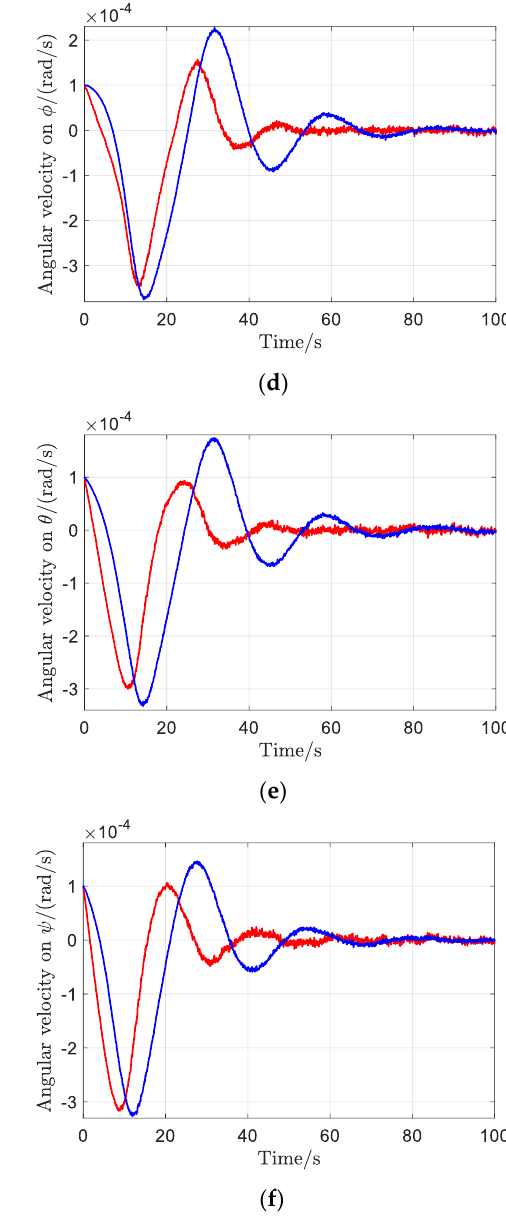
Figure 6. Time response comparisons of position and attitude of the test mass with the proposed RobCA method and the PICA method. ( a ) Position on x . ( b ) Position on y . ( c ) Position on z . ( d ) Attitude on ϕ . ( e ) Attitude on θ . ( f ) Attitude on ψ .